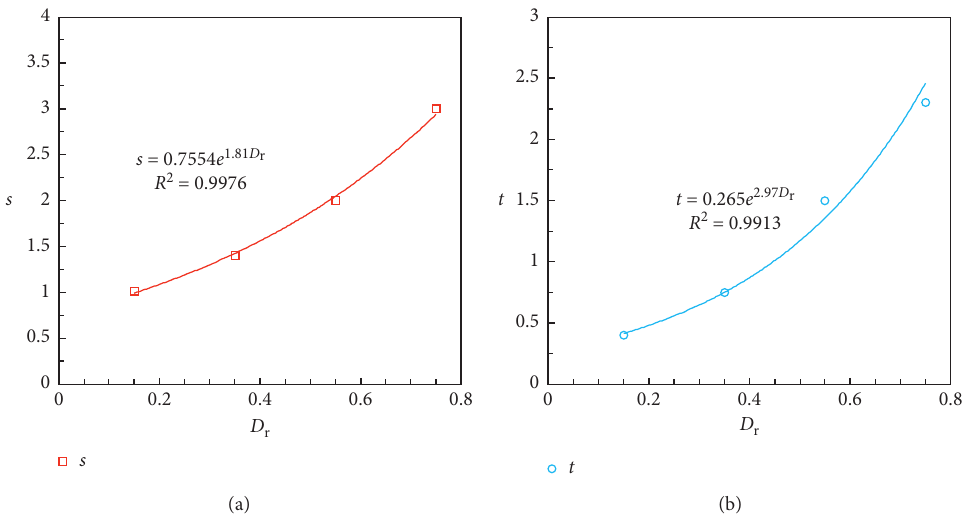
Figure 18: Relationships of D